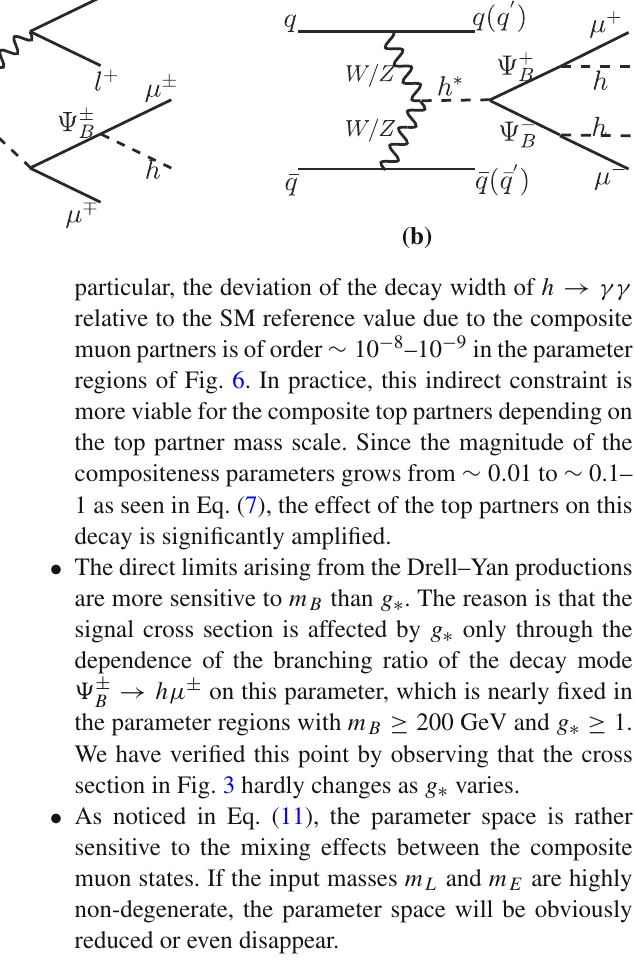
Fig. 4 Feynman diagrams for the h -associated single (left) and pair (right) production of (cid:8) B at the LHC